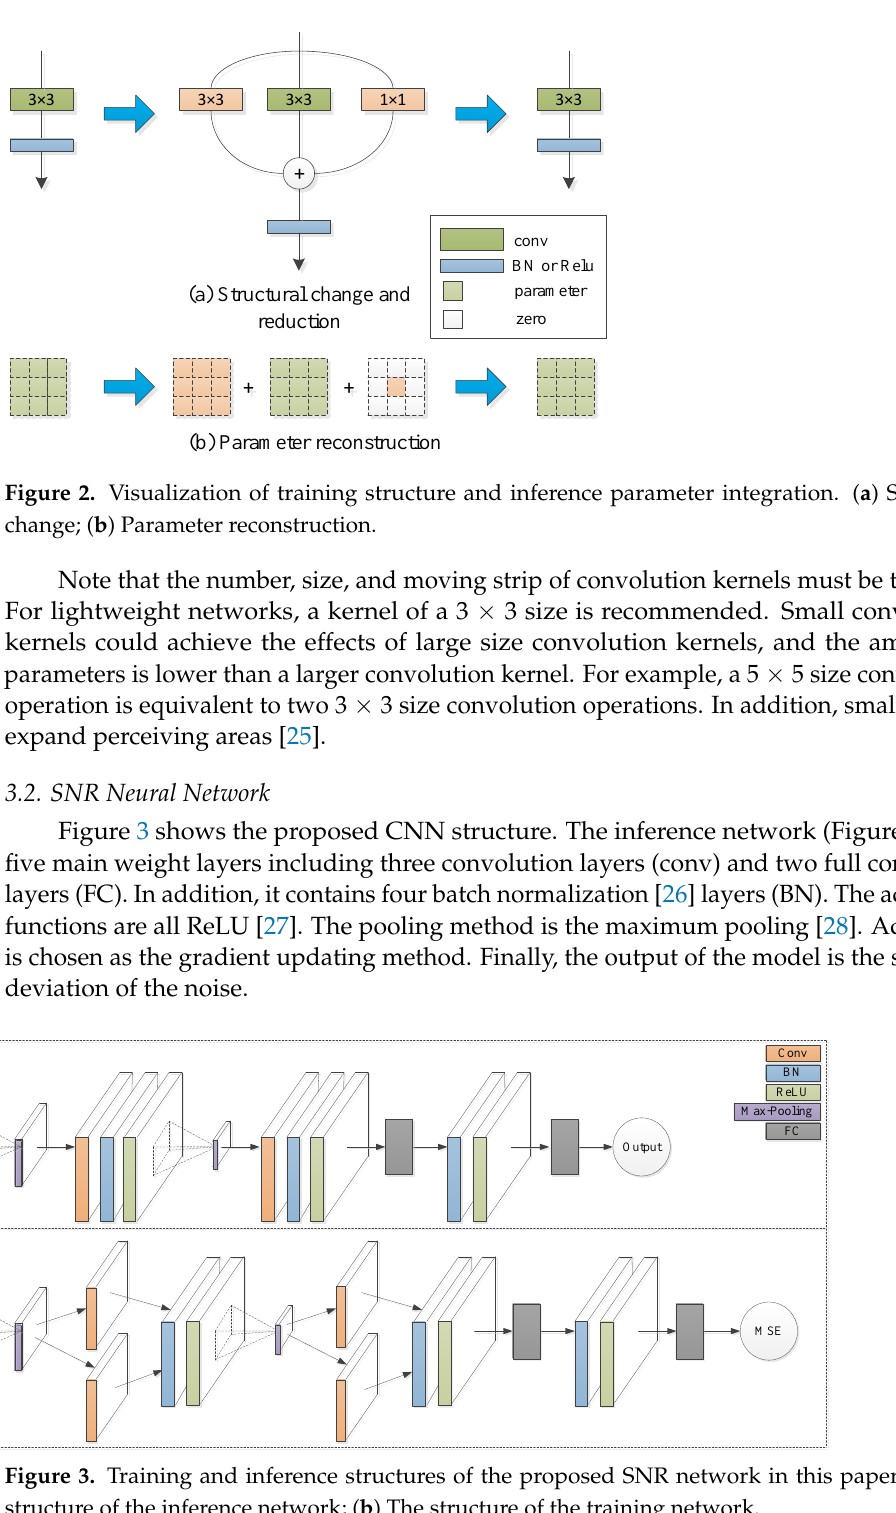
Figure 3. Training and inference structures of the proposed SNR network in this paper. ( a ) The structure of the inference network; ( b ) The structure of the training network.